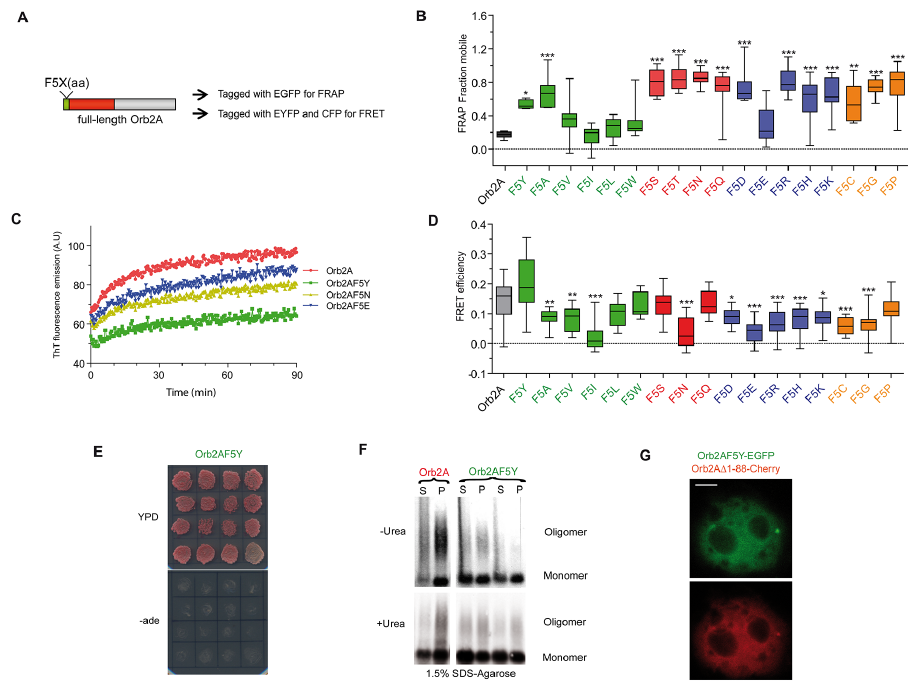
Fig 3. The F5 residue in Orb2A is critical for Orb2 amyloid-like oligomer formation and self-sustaining prion-like properties. (A) Schematic representation of the experimental design and the positions analyzed by the indicated methods. (B) FRAP was used to measure the dynamic nature of the Orb2A-EGFP aggregates, showing that substitution of the 5th residue makes the aggregates more dynamic. (C) The F5Y mutation reduces the rate of amyloid formation, as gauged by ThT fluorescence. (D) FRET was used to measure the relative orientation and organization of the Orb2A proteins in the aggregate. For Fig 3B and 3D analysis, data are represented as mean ± SEM. We assumed statistical significance at * p < 0.05, ** p < 0.01 and *** p < 0.001 (One-way ANOVA). (E) A single residue substitution in Orb2A, F5Y, dramatically reduced the ability to adopt the prion-like state. (F) Orb2A harbouring the F5Y mutation partitions less into the pellet fraction, and it forms less SDS-resistant oligomers than the wild type form. (G) Orb2AF5Y-EGFP did not induce oligomerization of Orb2A lacking the 88 N-terminal residues (Orb2A Δ 1-88-Cherry). Scale bar: 5 μ m. The underlying data for panels in this figure can be found in S1